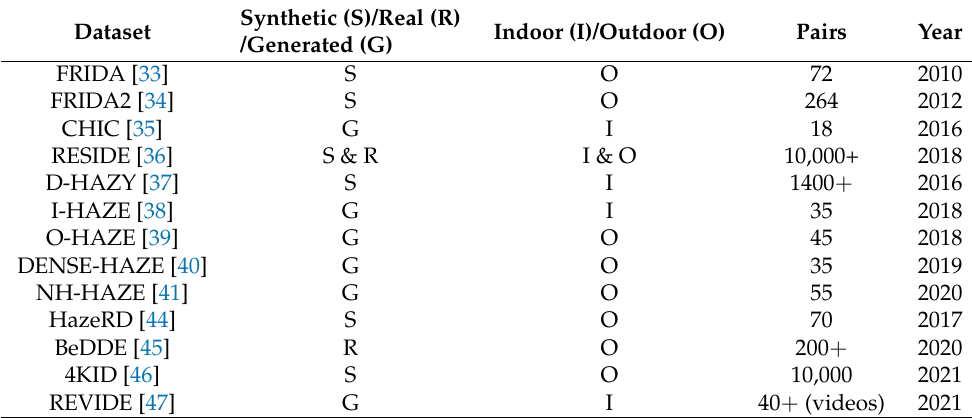
Table 3. Listing of datasets used for the dehazing